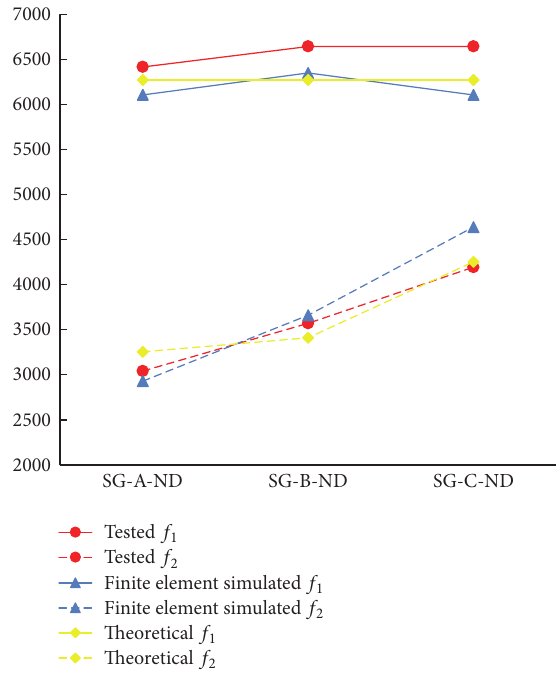
Figure 12: Comparison of theoretical values, test values, and finite element simulation values of peak frequency of samples (without defect).